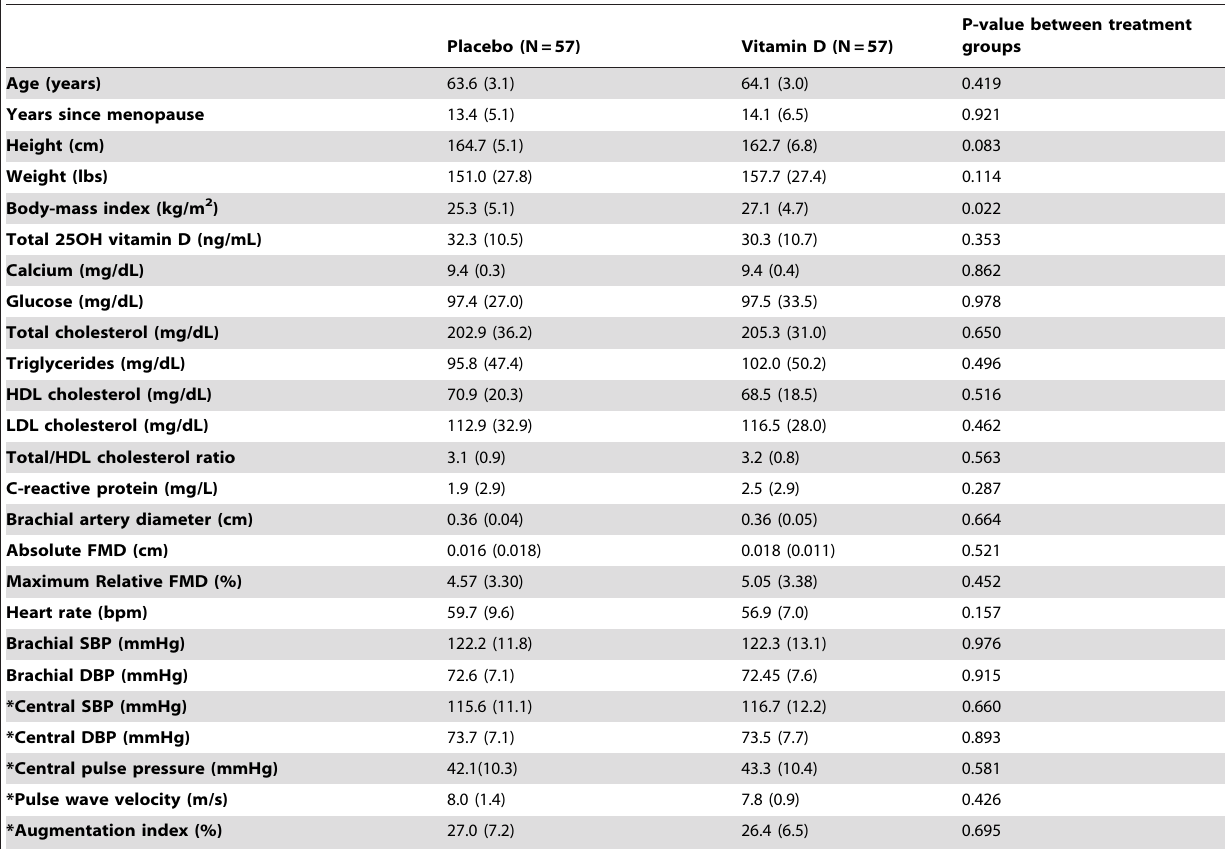
Table 1. Baseline Subject